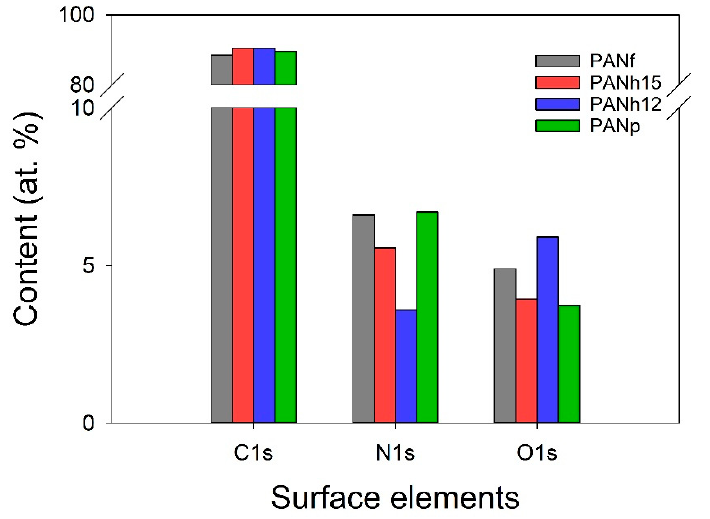
Figure 5. The atomic ratios of C 1s, N 1s, and O 1s obtained from the X-ray photoelectron spectroscopy (XPS) of the samples.